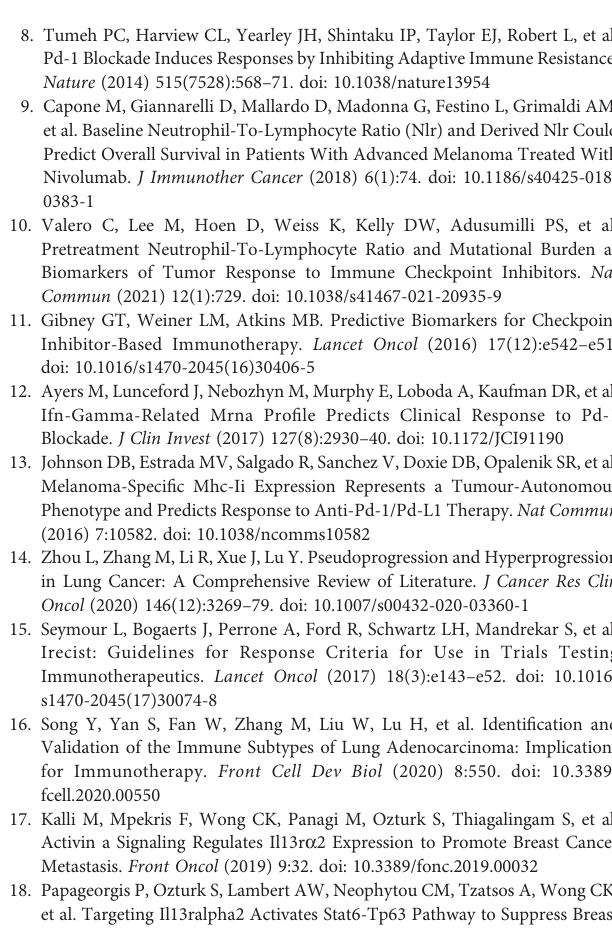
Supplementary Figure 1 | Kaplan-Meier survival curve of model immune terms, and the best cutoff of IRS in training and validation cohort. (A) Kaplan-Meier survival curve of model immune terms; (B) The best cutoff of IRS in training and validation cohort. Supplementary Figure 2 | GSEA enrichment analysis of IRS. (A) GSEA enrichment analysis of IRS model with all the GSEA gene set; (B) Representative pathway of each gene set. Supplementary Figure 3 | The overview of gene mutation of TCGA-NSCLC. Supplementary Figure 4 | Univariate and multivariate Cox regression analysis of IRS and clinical features. (A) Univariate Cox regression analysis of IRS and clinical features; (B) Multivariate Cox regression analysis of IRS and clinical